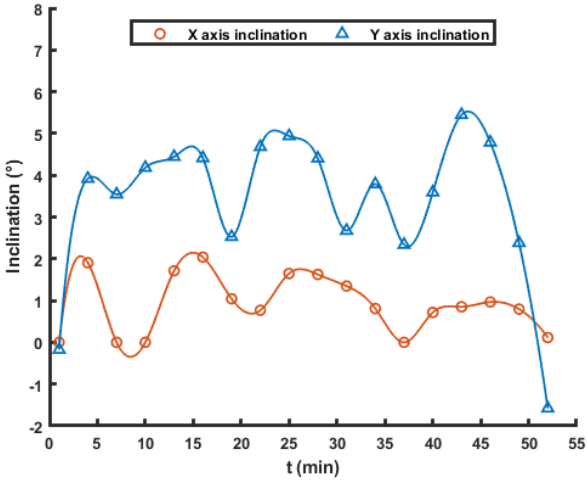
Figure 20. Relationship curve of inclination versus time.